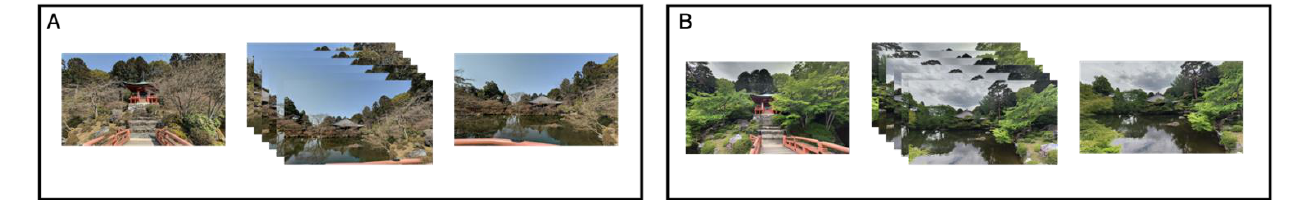
Figure 7. Sample frame images of ( A ) C2 and ( B ) C20. C2 and C20 are panoramic video clips of almost the same observation point in H15. C2 is the winter vision and C20 is the summer vision.